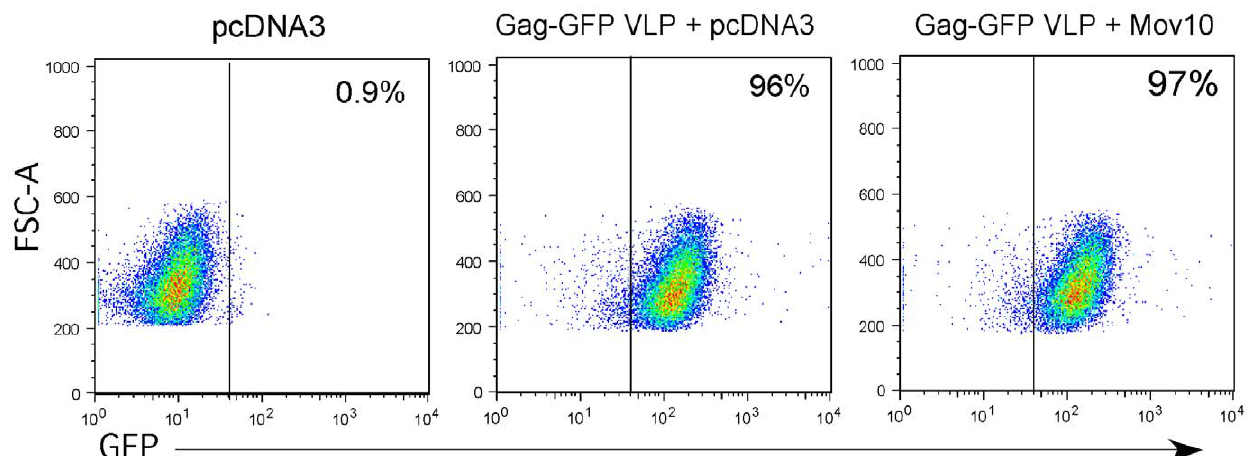
Figure 6. Viral glycoprotein incorporation is not affected by Mov10 overexpression. 293T cells were transfected with plasmids necessary for the production of VSV-G pseudotyped Virion-Like Particles (VLPs) containing a GFP tag (as a Gag-GFP fusion) as well as either control or Mov10. Supernatant from these cells was then collected and added to Jurkat T cells and assayed for binding to target cells. Cells bound by one or more VLPs are GFP + by FACS.